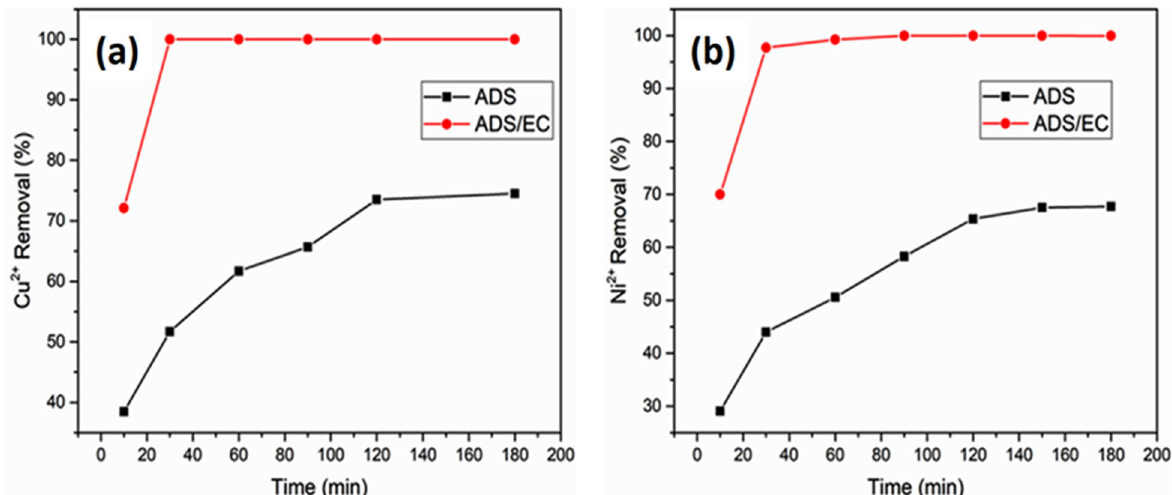
Figure 5. Effect of time on ( a ) Cu 2+ and ( b ) Ni 2+ removal synthesized wastewater during the ADS and ADS/EC coupling processes (activated green waste tea dose = 1 g L −1 , Initial conc. = 20 mg L −1 and Current density = 1.19 mA cm −2 ).